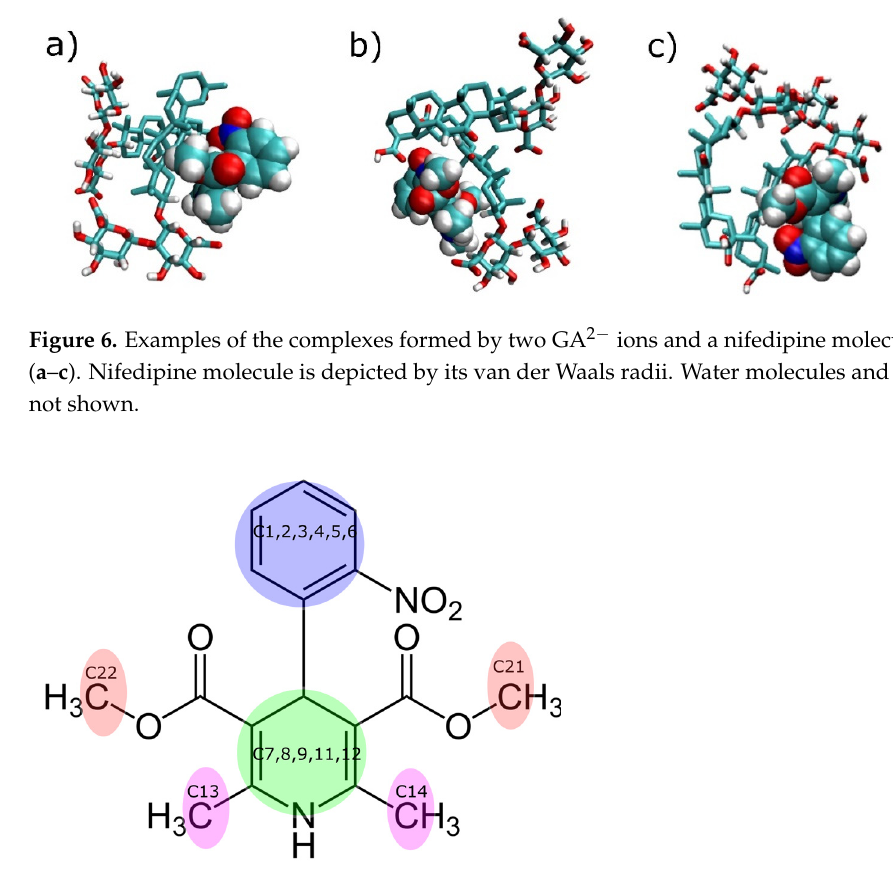
Figure 7. Moieties of a nifedipine molecule, which were used to measure distances from C13, C14 and C21, C22 carbon atoms of methyl groups, the pyridine ring and benzene ring are highlighted by magenta, red, green, and blue, respectively.